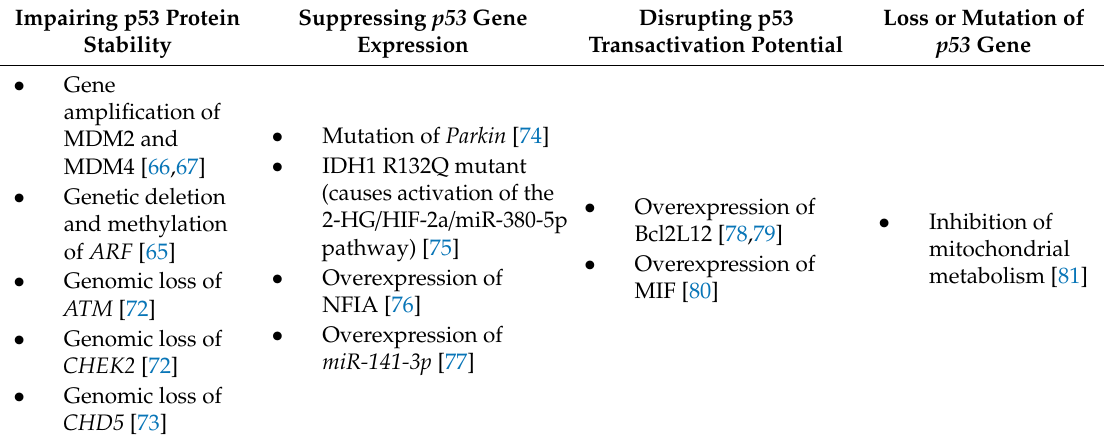
Table 2. Mechanisms of inactivating p53 in brain